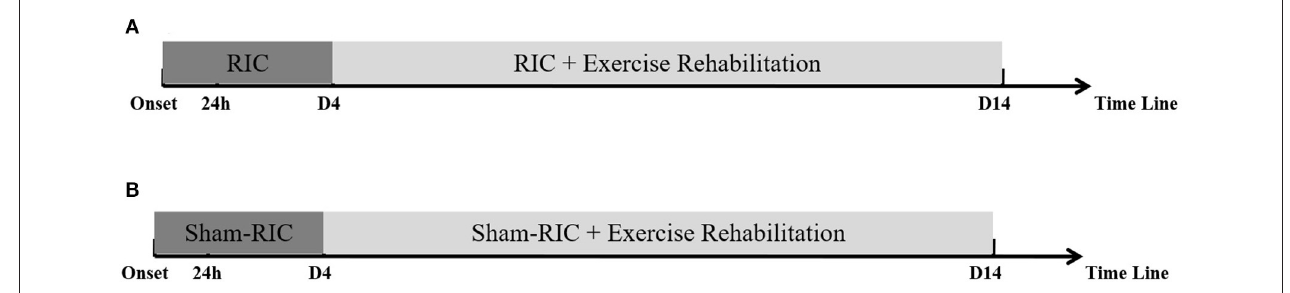
FIGURE 1 | Procedure timeline for experimental protocol. (A) RICE group (RIC with exercise); (B) Control group (Sham-RIC with exercise).